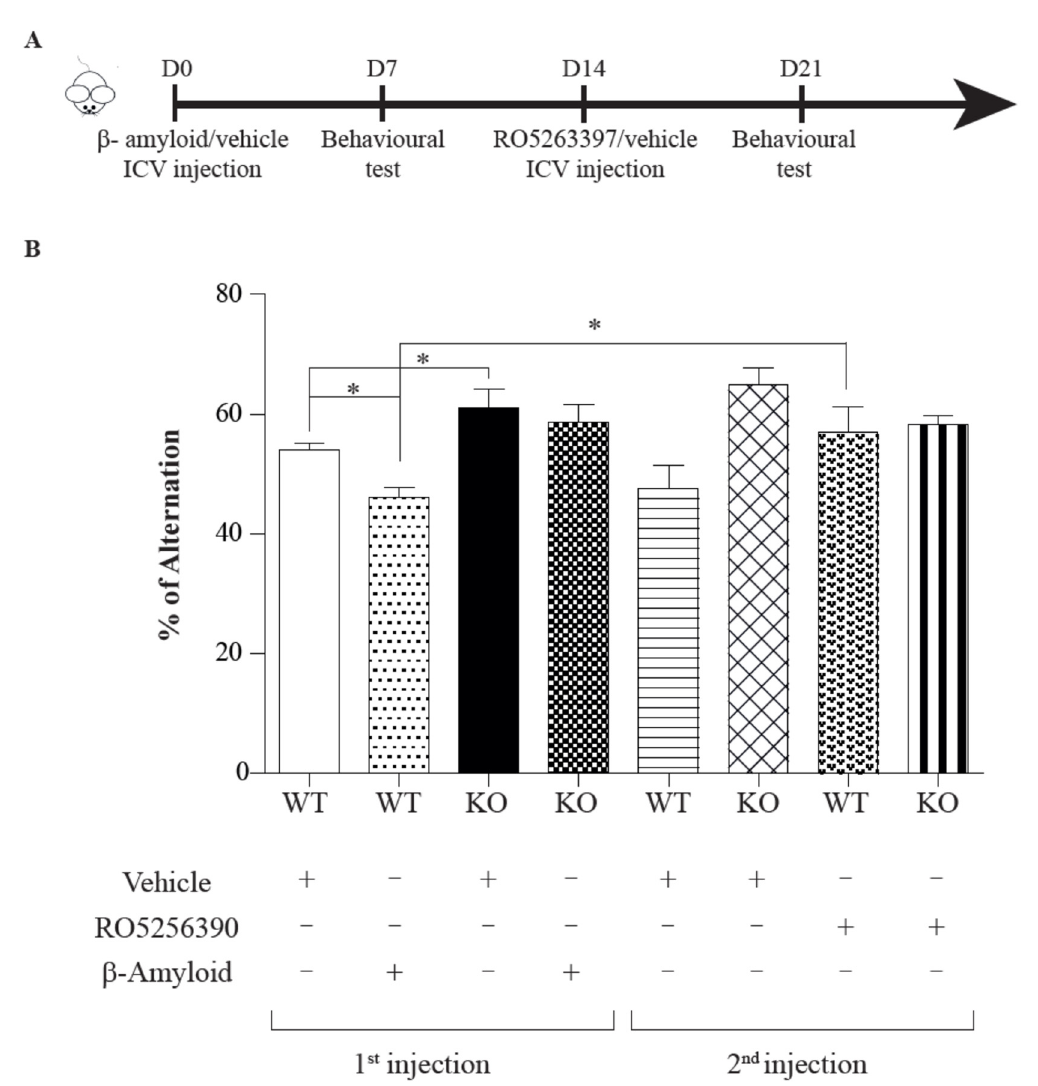
Figure 5. ( A ) Protocol of the A β -induced mouse model and behavioural analysis (n = 12 mice/group). ( B ) ICV A β infusion is able to induce a slight cognitive impairment in control animals while the KO seem to be more resistant to A β effects (* p < 0.05). Furthermore, neither the vehicle nor the TAAR1 agonist administration influenced the Y-maze performance in both control and knockout